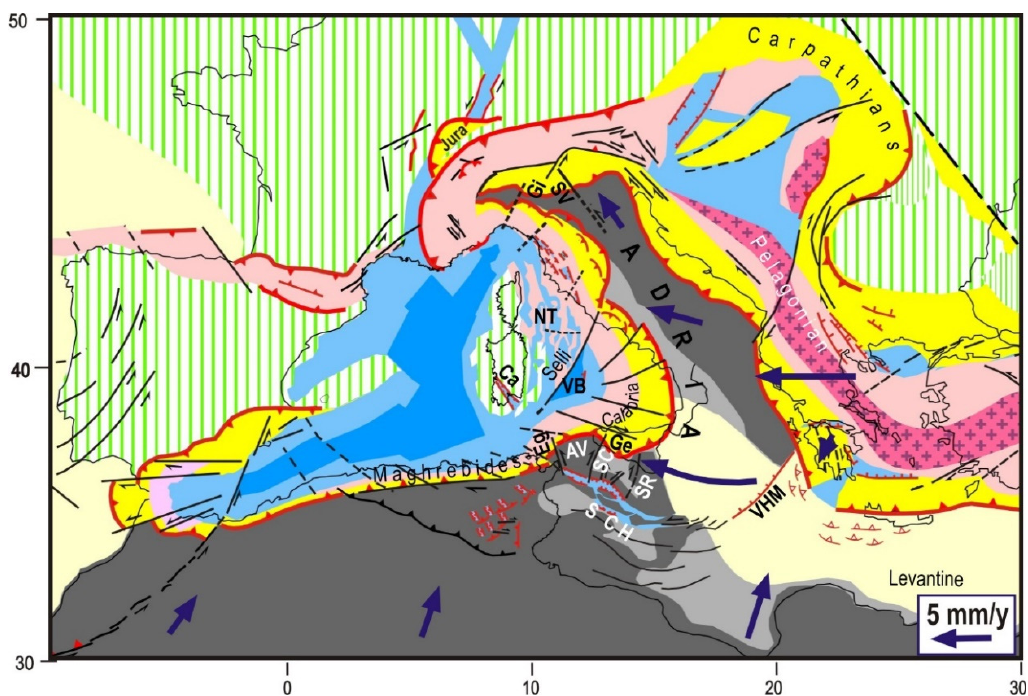
Figure 7. Middle Pliocene tectonic setting. The westward push of the Anatolian–Aegean–Pelagonian system causes the decoupling of the Adria plate from Nubia by the activation of the Victor Hensen–Medina-Sicily Channel fault system. Once decoupled, Adria underwent a clockwise rotation and a minor NW ward motion. The rotation determined major E-W shortening in the Pelagian zone as well as in the Alpine–Maghrebian and Alpine–Apennine zones, whereas the NW displacement of Adria caused the activation of the Schio–Vicenza fault system in the northern Adriatic domain. AV = Adventure wedge, Ca = Campidano graben, CT = Central Tyrrhenian, Eg = Egadi fault, Ge = Gela nappe, Gi = Giudicarie fault system, NT = Northern Tyrrhenian, SCH = Sicily Channel, SC = Sciacca fault, SR = Scicli–Ragusa fault, SV = Schio–Vicenza fault, VB = Vavilov basin, VHM = Victor Hensen–Medina fault. Colours and symbols as in previous evolutionary maps.